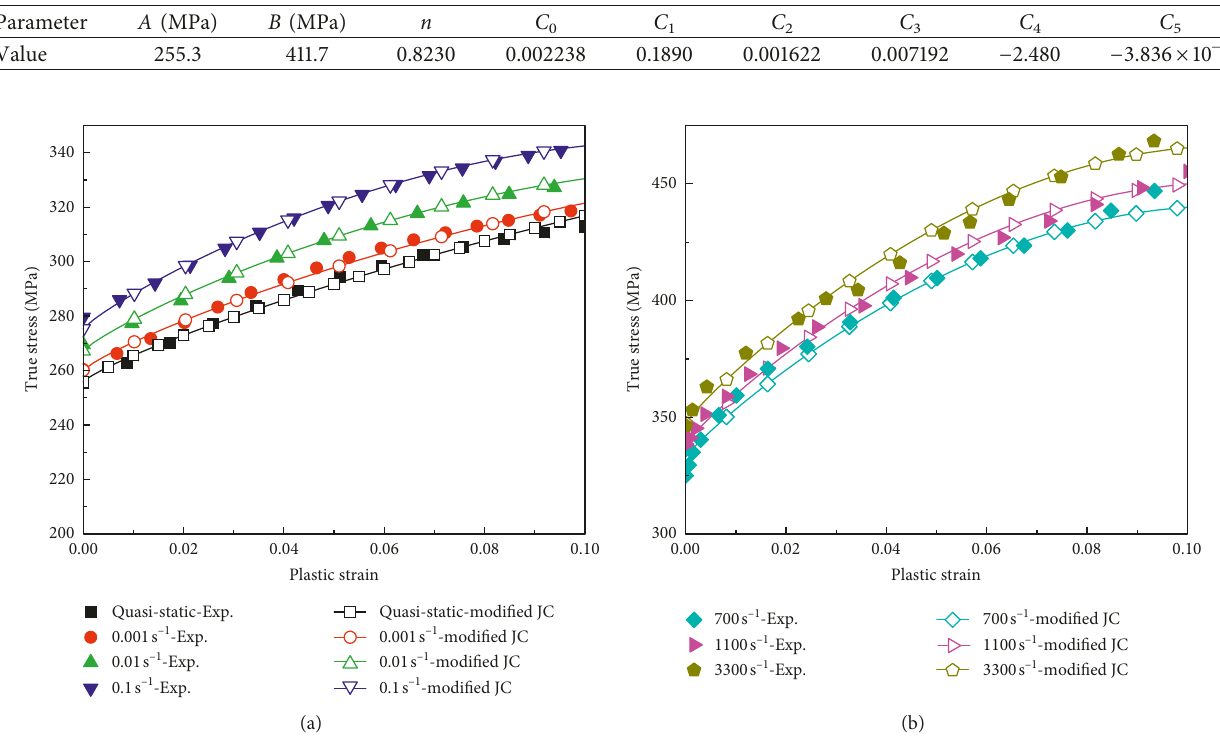
Table 6: The material constants of the modified JC constitutive model of 6005 Al alloy.